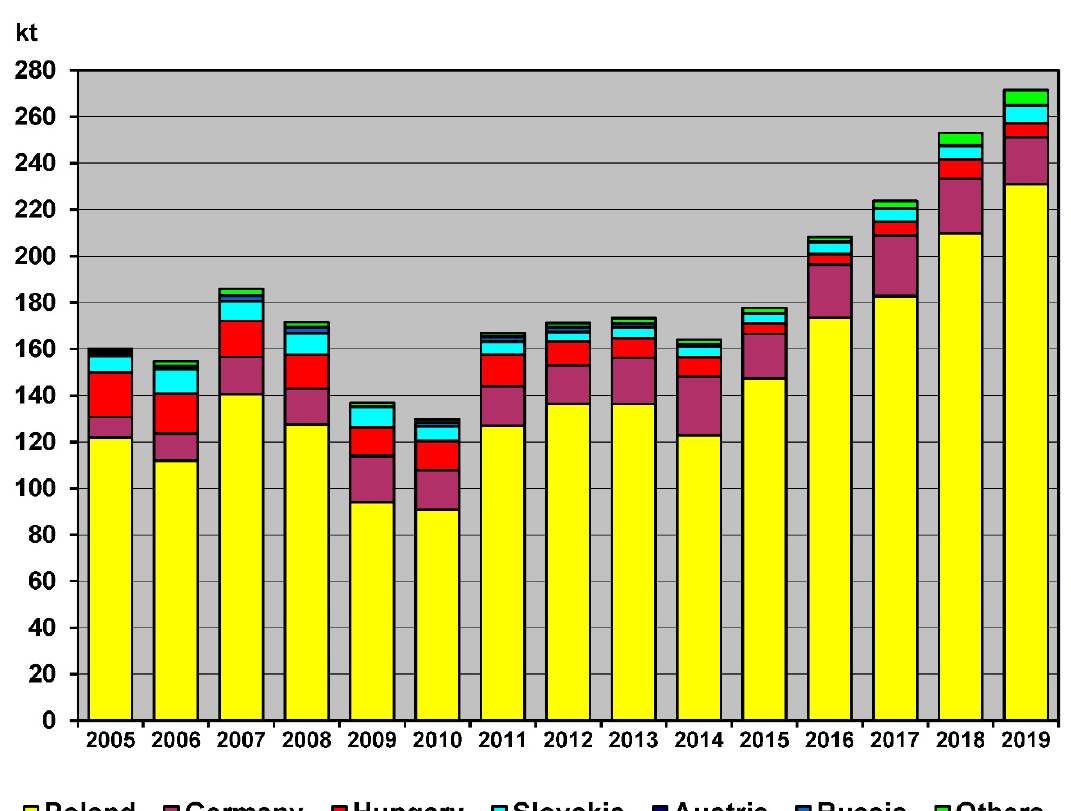
Figure 11. Distribution of Czech feldspar exports.